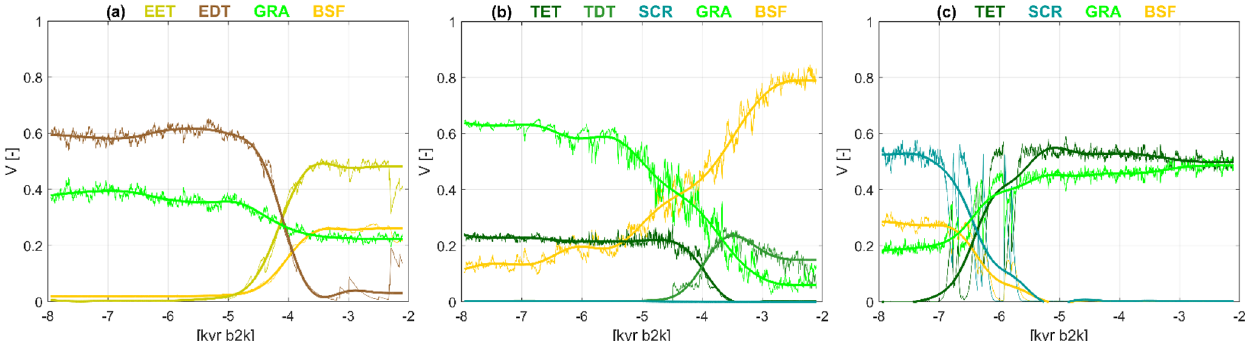
Figure 13. Examples of rapid transitions between simulated PFTs in a grid cell in (a) East Siberia (at the grid cell centred at 62.49 ◦ N, 120 ◦ E, in region 2 in Fig. 12), (b) today’s Sahara–Sahel region (at 19.59 ◦ N, 7.5 ◦ W, in region 3) and (c) South Asia (at 19.59 ◦ N, 78.75 ◦ E, in region 4), shown as fractional coverage V ( t ) as function of time t , given as kyrb2k. The colours refer to different PFTs as indicated in the title line. EET: extratropical evergreen trees; EDT: extratropical deciduous trees; TET: tropical evergreen trees; TDT: tropical deciduous trees; SCR: shrubs; GRA: grass; BSF: bare soil fraction. The thin lines are annual values of fractional vegetation coverage, and the thick lines are filtered time series using a Butterworth filter of the order of 5 with a low-pass filter of 500 years.